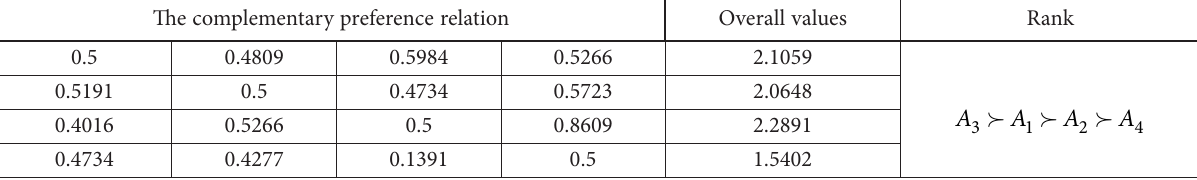
Table 5. The complementary preference relation and the rank of alternatives The complementary preference relation Overall values Rank